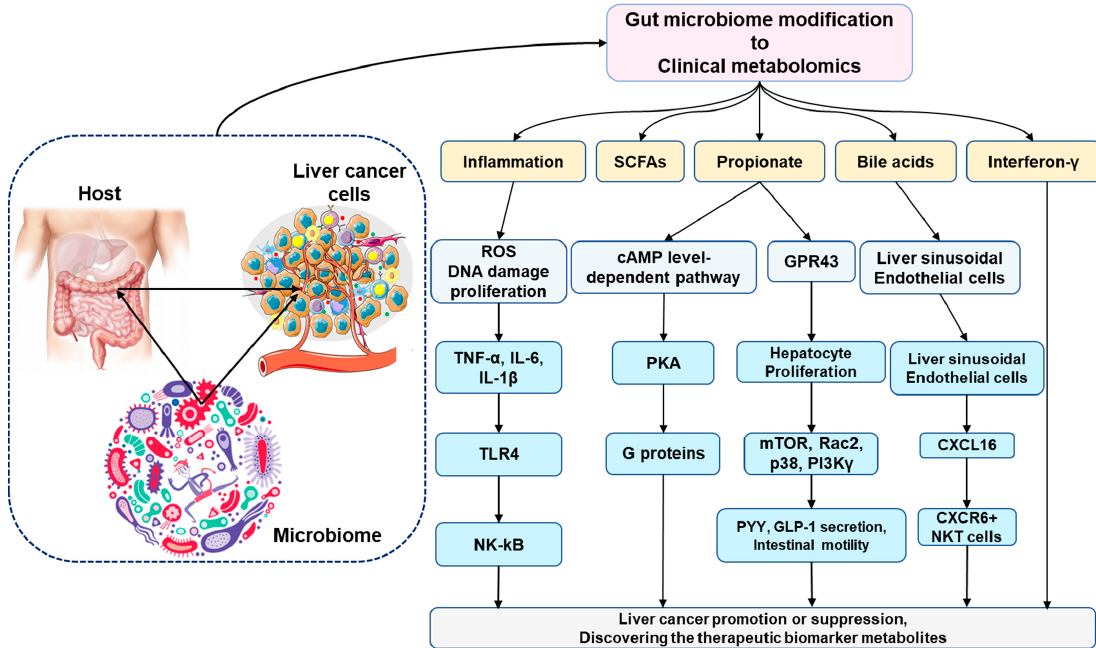
Figure 2. A three ‐ way relationship between the host, tumor microenvironment, and microbiota. The gut microbiome ‐ derived metabolomics target in HCC has been summarized. The host microbiome and metabolic reprogramming for cancer cells and their microenvironment may be related. An al ‐ tering gut microbiota may boost propionate synthesis, which may reduce the risk of HCC both through a cAMP level ‐ dependent mechanism and by interacting with GPR43. The gut microbiota alteration may result in an anti ‐ HCC impact by boosting the amount of hepatic CXCR6+, NKT cells, and IFN ‐γ production. Primary ‐ to ‐ secondary bile acid conversion, which is controlled by the gut microbiota, influenced the CXCL16 expression of liver sinusoidal endothelial cells, which in turn affected the accumulation of CXCR6+ and NKT cells. cAMP, cyclic adenosine monophosphate; GPR, G protein ‐ coupled receptor; IFN, interferon; IL, interleukin.